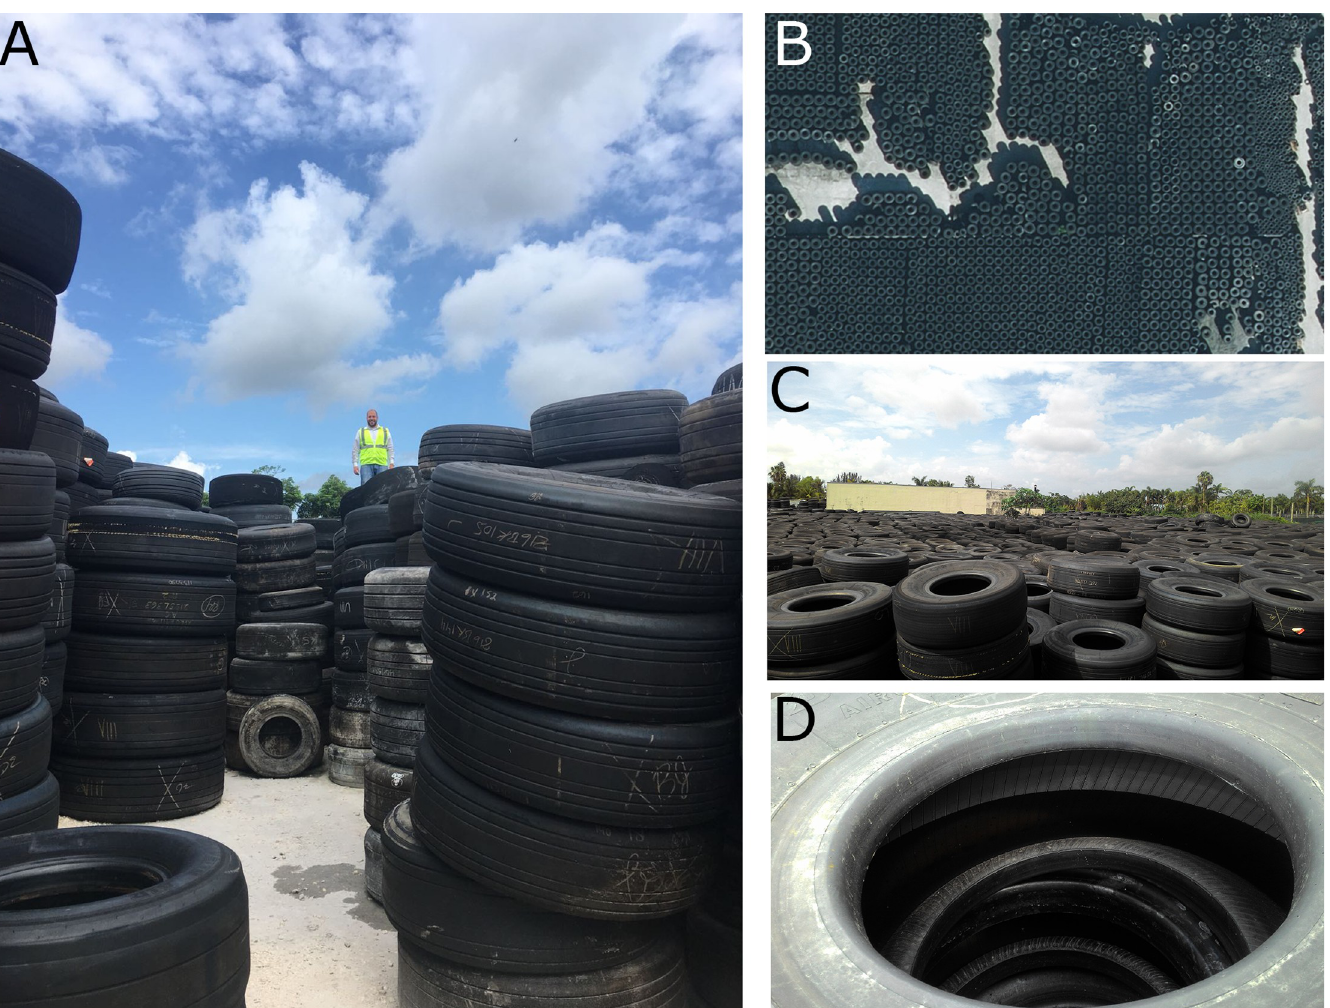
Fig 2. Tire shop environment. (A) Tire stacks; (B) aerial view of the tire shop; (C) view of the tire shop from the top of the tire stacks; and (D) tires filled with water organized in a stack.